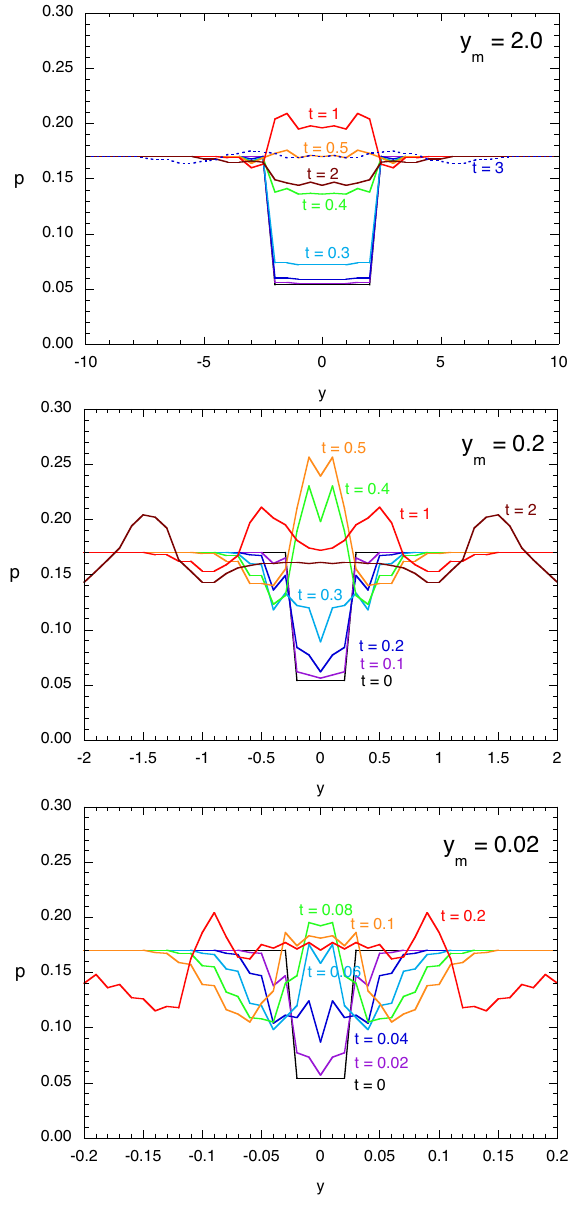
Fig. 1. Plasma pressure at x =− 7 . 4 ,z = 0 as a function of y at dif- ferent times and for 3 different bubble widths, as